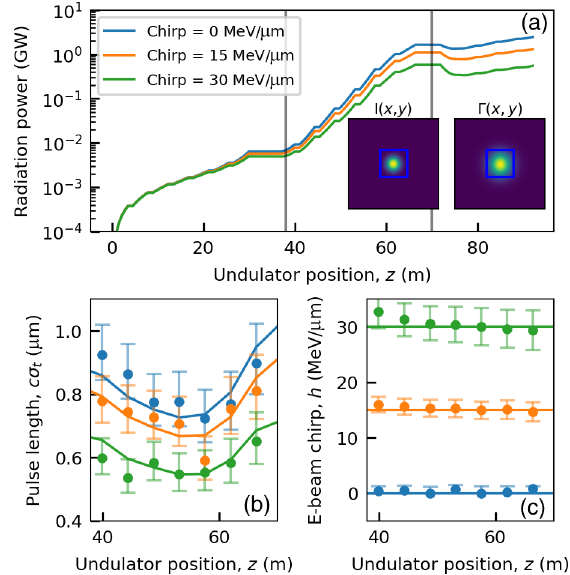
FIG. 6. Results from 3D simulations for three different values of the e-beam chirp. (a) shows the average radiation power for 0, 15, and 30 MeV = μ m chirp. (b) and (c) show the reconstructed pulse length and chirp (dots) alongside the true values obtained from the simulations (lines) in the exponential gain and early saturation regimes. (a) also shows the average far field transverse intensity profile as well as the transverse intensity correlation function Γ ð x; y Þ at z ¼ 57 . 5 m. The image axes run between (cid:3) 100 μ m in both directions.